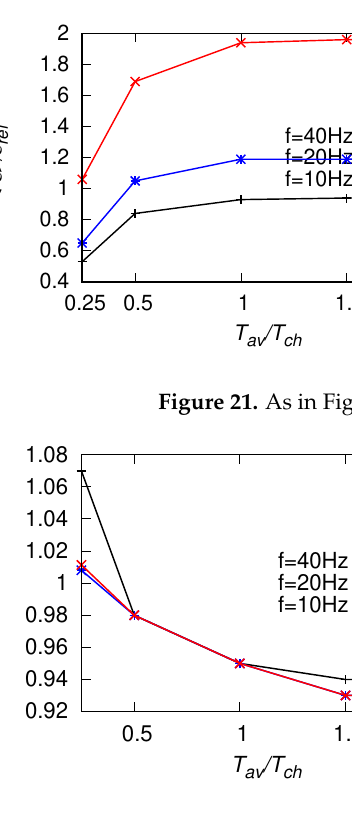
Figure 22. Statistics of (cid:101) SF estimates based on the structure function, Equation (7), for the fitting range f = [ 1 ÷ 5 ] Hz, from POST signals [15] with f s = 40 Hz, 20 Hz and 10 Hz. Left panel : EDR averaged along the signal, right panel : standard deviation of the